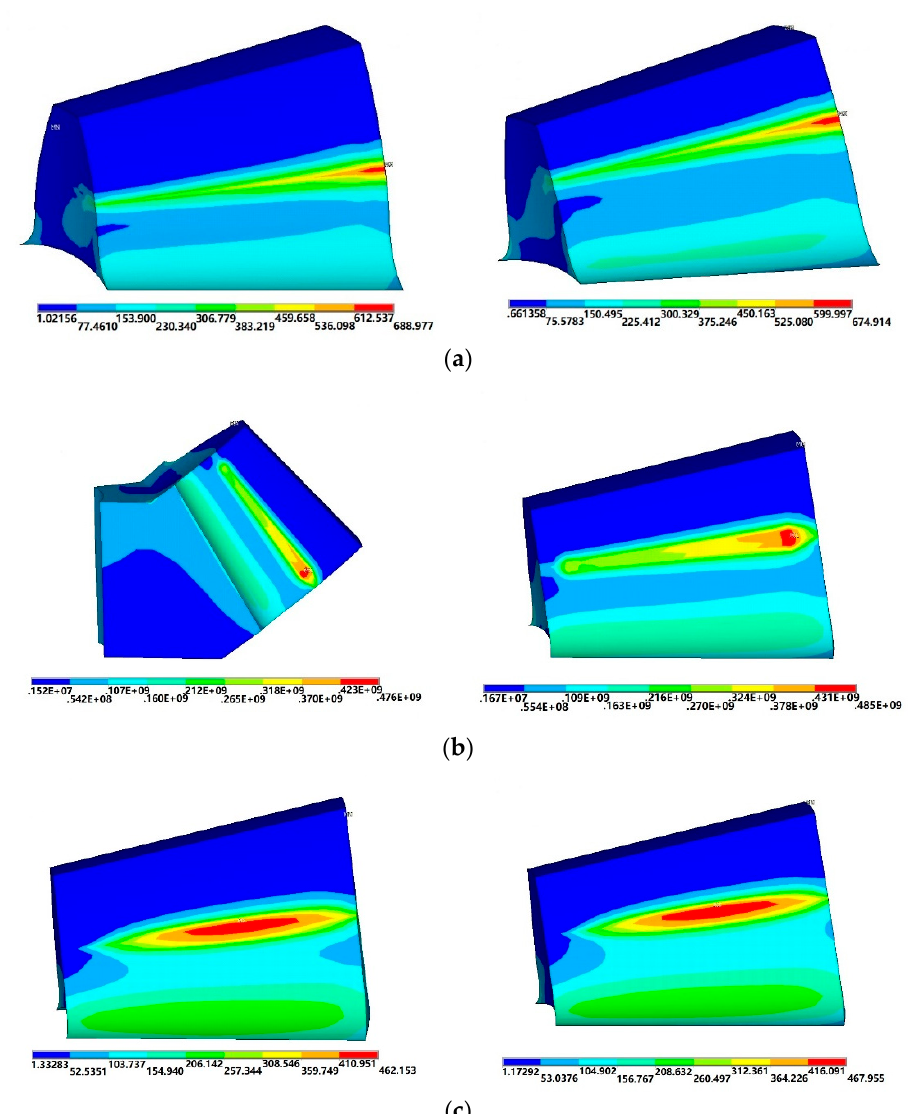
Figure 14. Distribution of contact stress on the tooth surface for pinion (left) and the gear (right) when ∆ E = − 0.02. ( a ) No modification, ( b ) Case4 and ( c ) Case1.